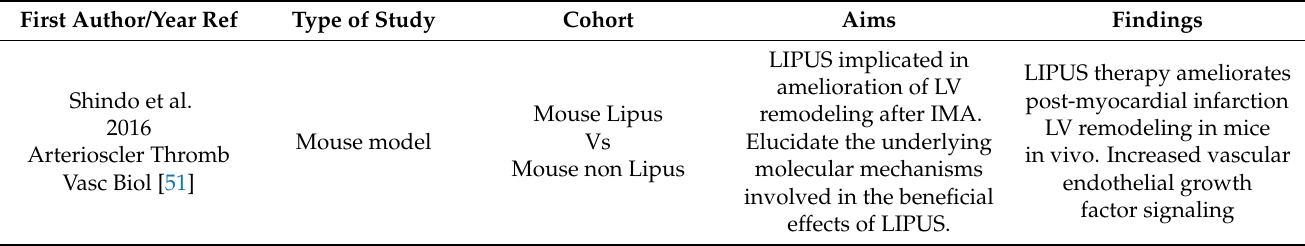
Table 2. Pivotal studies identifying the role of shear stress and perivascular adipose tissue. The references represent the progression in the text according to those reported in the PRISMA